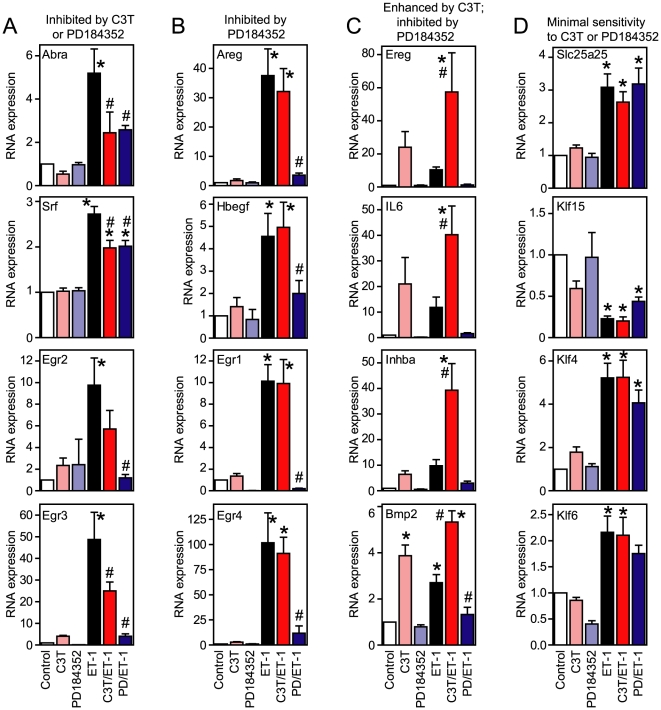
Validation of microarray data.Cardiomyocytes were unstimulated (Control) or exposed to ET-1, C3T, PD184352 or ET-1 together with C3T (C3T/ET-1) or PD184352 (PD/ET-1). ET-1 responsive mRNA expression was measured by qPCR. A, mRNAs inhibited by either C3T or PD184352. B, mRNAs inhibited by PD184352. C, mRNAs enhanced by C3T but inhibited by PD184352. D, mRNAs insensitive to either drug. Results (relative to controls) are means ± SEM (n = 4 or 5). *p<0.05 relative to Control; #p<0.05 relative to ET-1 (one way ANOVA repeated measures with Newman-Keuls post-test).